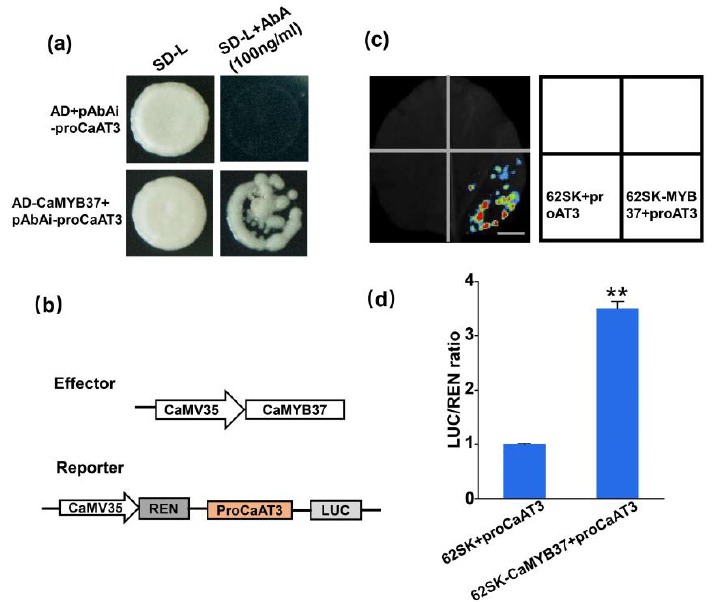
Figure 8. CaMYB37 binds to the promoter of AT3 and promotes its transcription. ( a ) DNA-binding potential of CaMYB37 with the promoter of AT3 in yeast. SD/−L, medium lacking leucine. ( b ) Vectors for dual luciferase experiments. ( c ) LUC images of tobacco leaves after transient infiltration. Scale bars, 1 cm. ( d ) Enzyme activity detections in dual luciferase assays. Error bars indicate means ± SEs ( n = 6). ** means extremely significant difference ( p < 0.01).